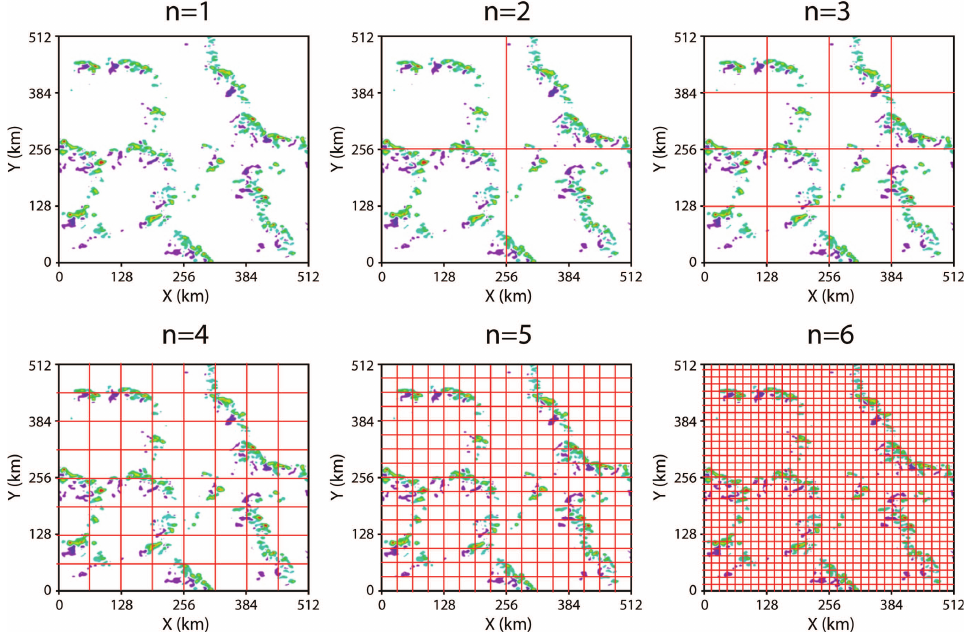
Fig. 7. The original domain and examples of the sub-domains used for analysis.